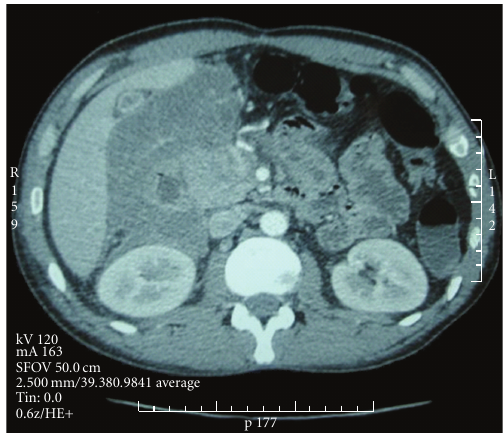
Figure 1: CT-scan showing the retroperitoneal mass.